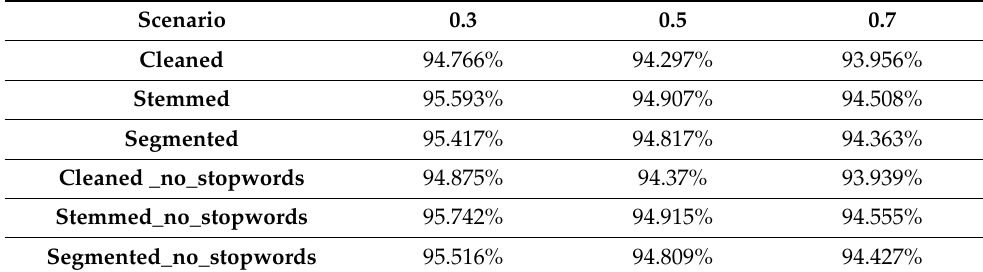
Table 1. Summary of accuracy results with different testing